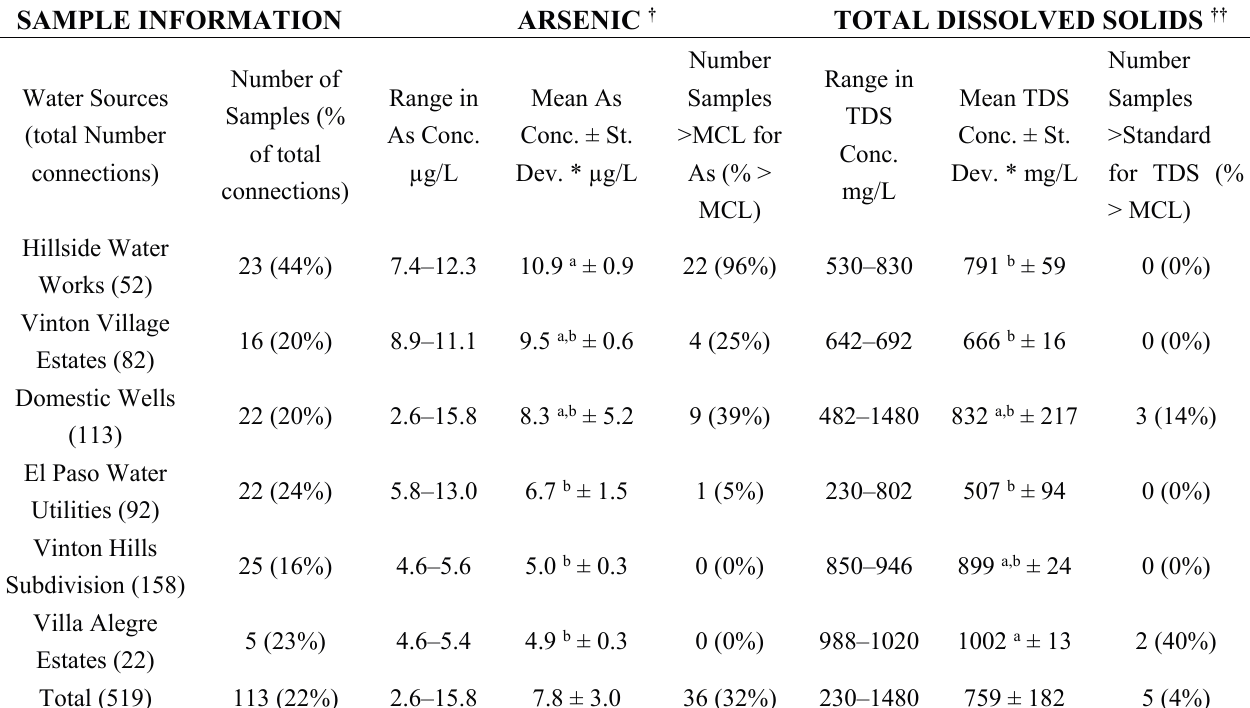
Table 3. Arsenic (As) and total dissolved solid (TDS) concentrations and related parameters for different water sources in